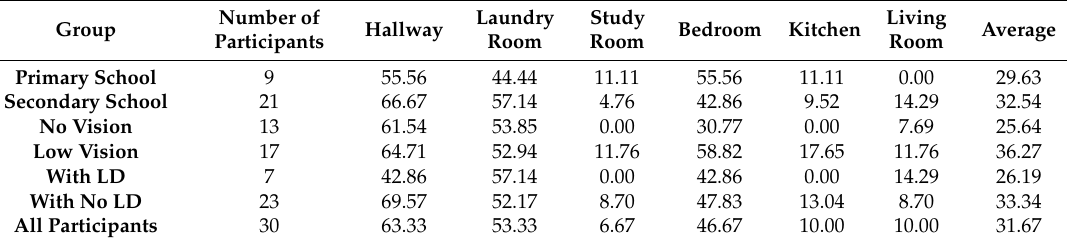
Table 2. Success Rate (%) of Food Finding Test in Various Groups.